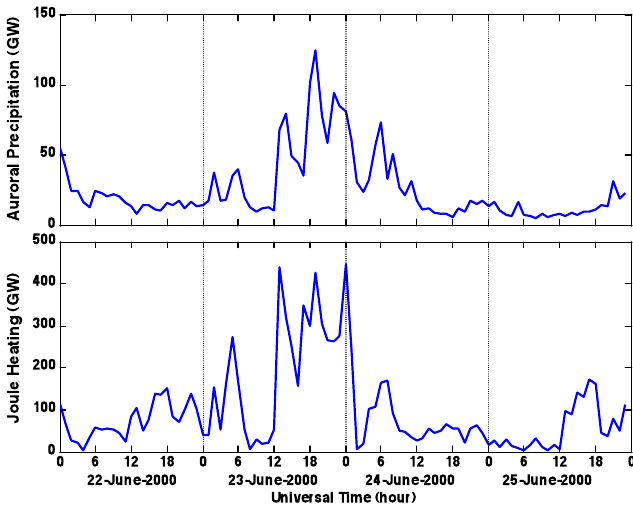
Figure 3. Solar wind energy in thermosphere-ionosphere system for June 22-25, 2000. Top: Auroral precipitation. Bottom: Joule